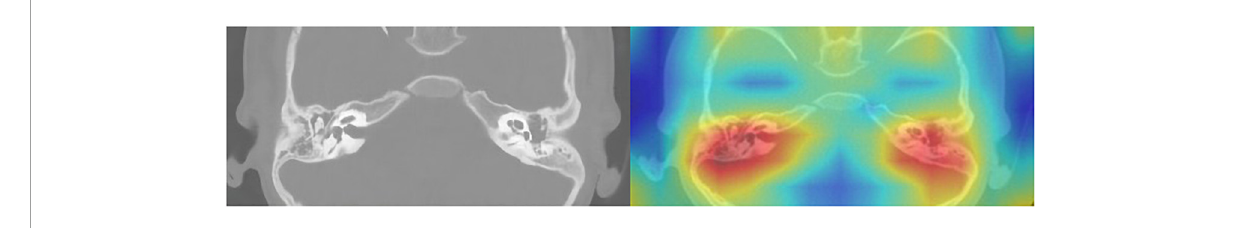
FIGURE3 CT of the temporal bone with cholesteatoma: Original image (left) and heat map (right) .